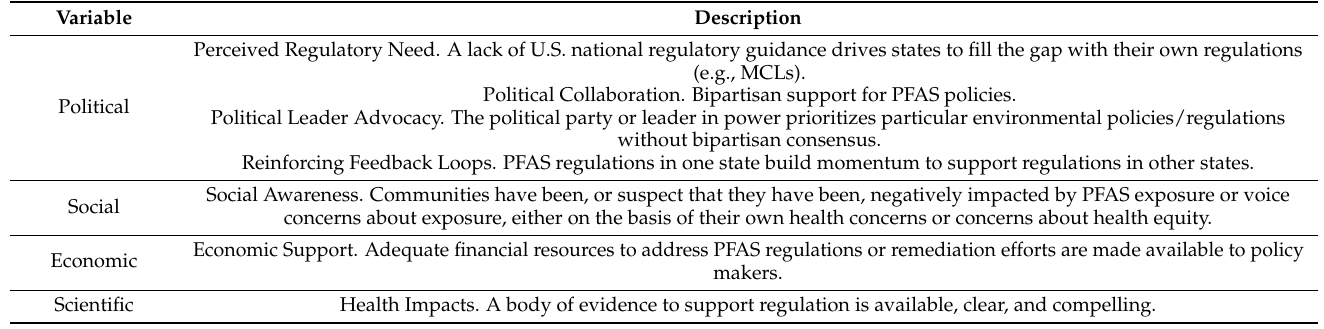
Table 4. Variables and sub-variables that drive adoption of PFAS-related laws, policies, and regulations. Variable Description